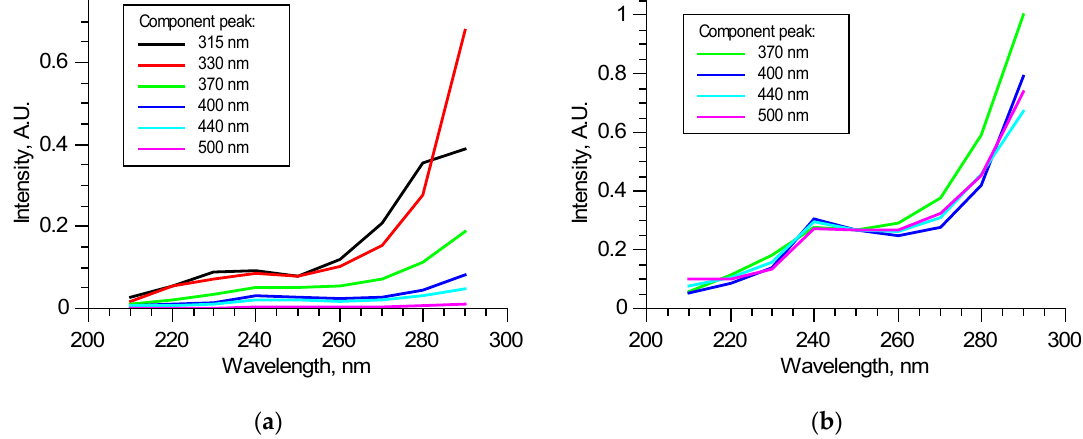
Figure 6. Example of excitation spectra of the specified components in a normalized excitation–emission matrix ( a ) and normalized on 250 nm excitation contributions ( b ).